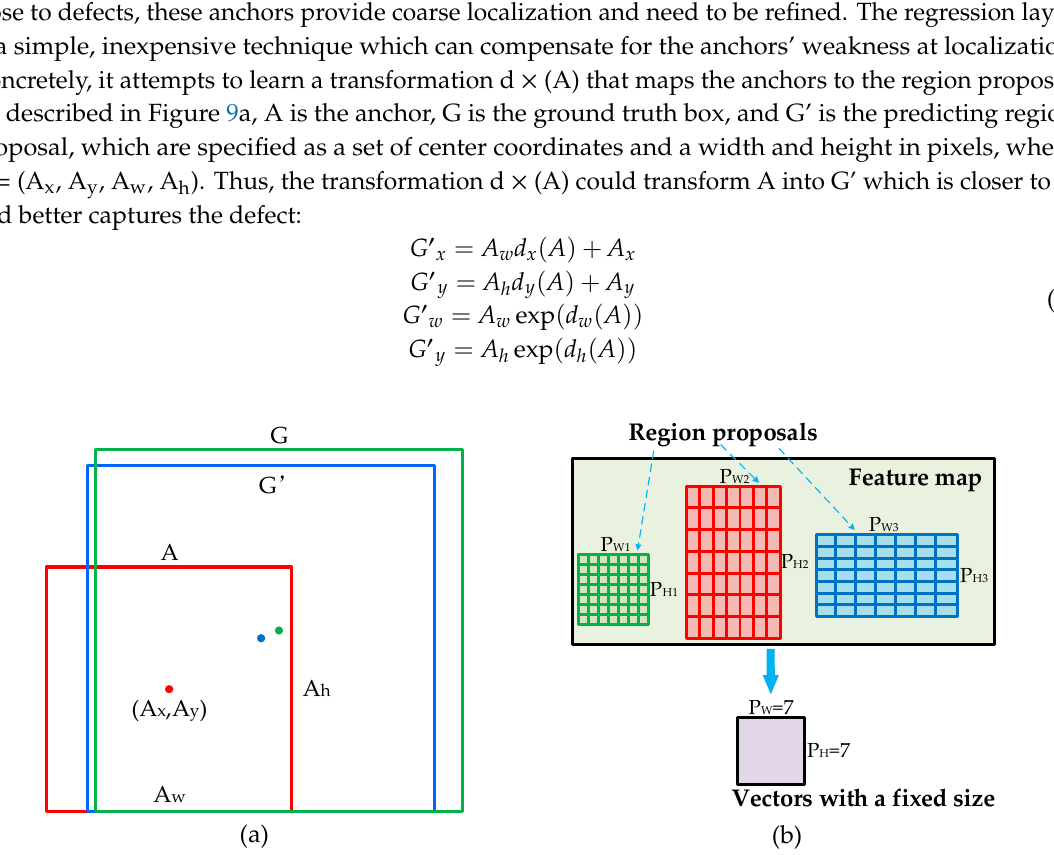
Figure 9. ( a ) The schematic diagram of the regression layer; ( b ) ROI pooling.